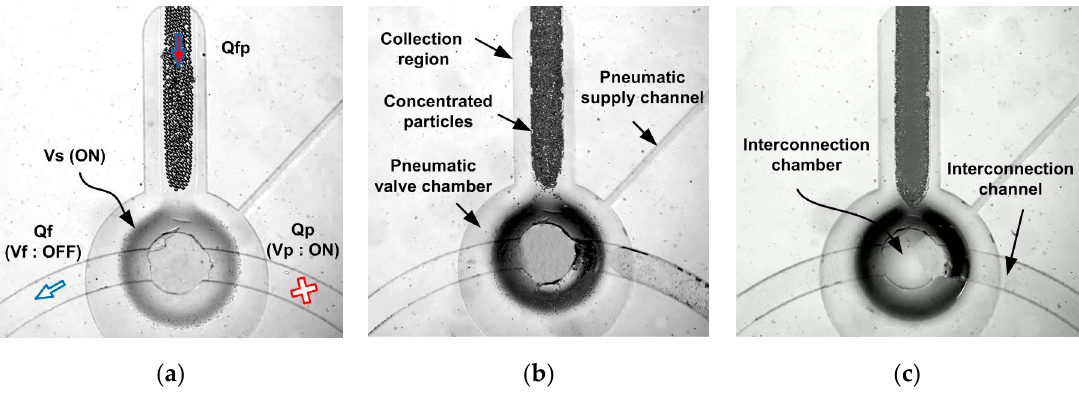
Figure 8. Concentrated particles of various diameters. ( a ) 24.9 µm, ( b ) 8.49 µm, ( c ) 4.16 µm.